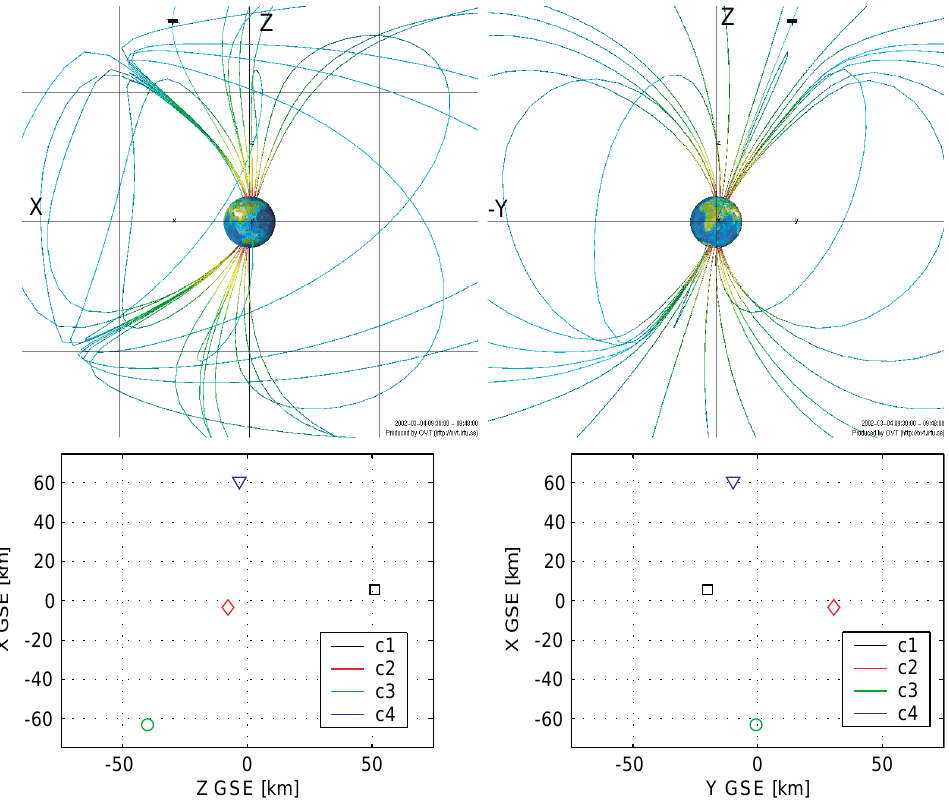
Fig. 1. Location of Cluster spacecraft (marked by a black bar) in the magnetosphere at 09:35 UT: X–Z (right) and Y–Z (left) views and Cluster configuration in GSE (lower panels). The figure is produced with Orbit Visualization Tool